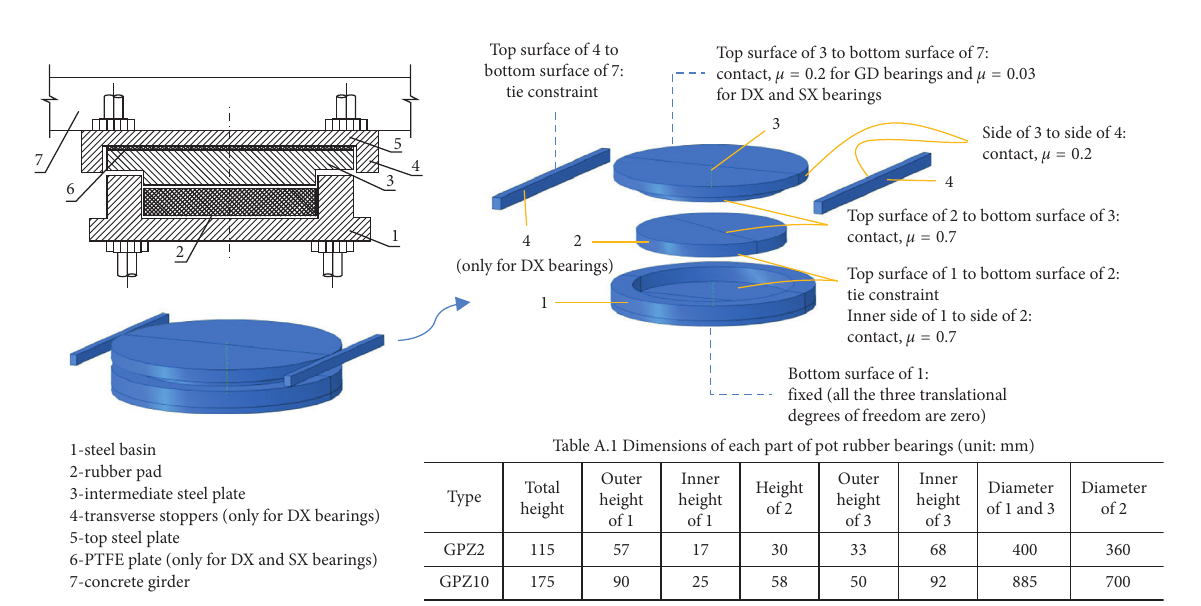
Figure 5: Constructions, dimensions, and contact parameters of the pot rubber bearings in the